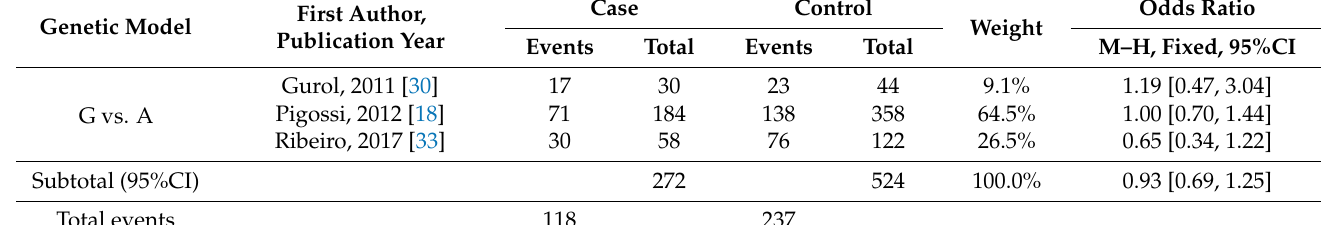
Table 4. Results on the association of the five genetic models of IL-10 ( − 1082 A > G) polymorphism with the risk of PID. Genetic Model